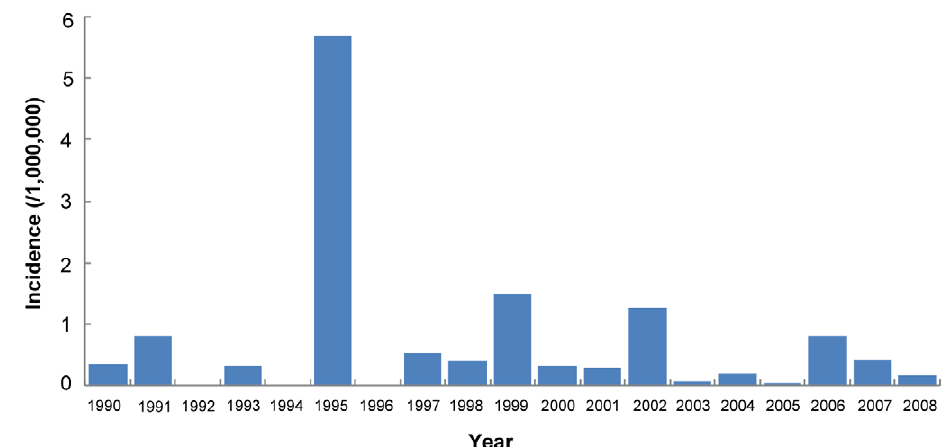
Figure 3. Dengue incidence from 1990–2008 in mainland China.